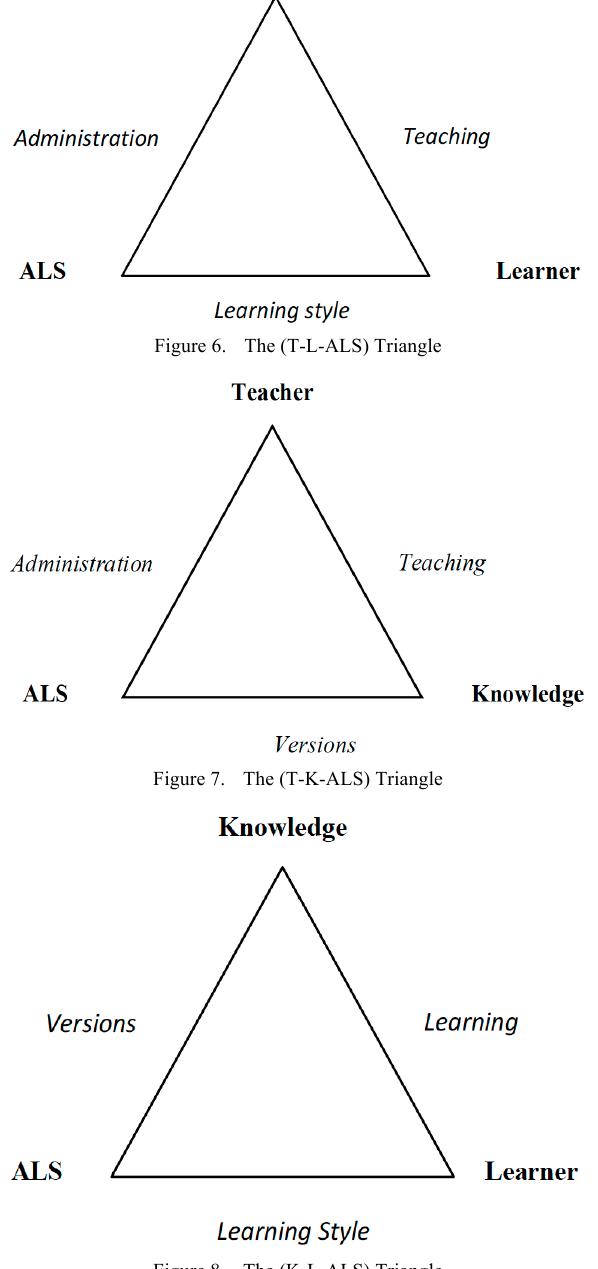
Figure 8. The (K-L-ALS)